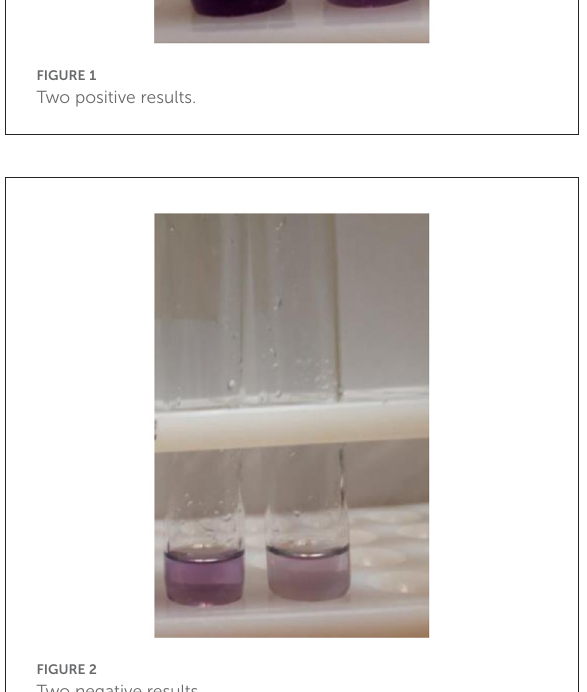
FIGURE2 Two negative